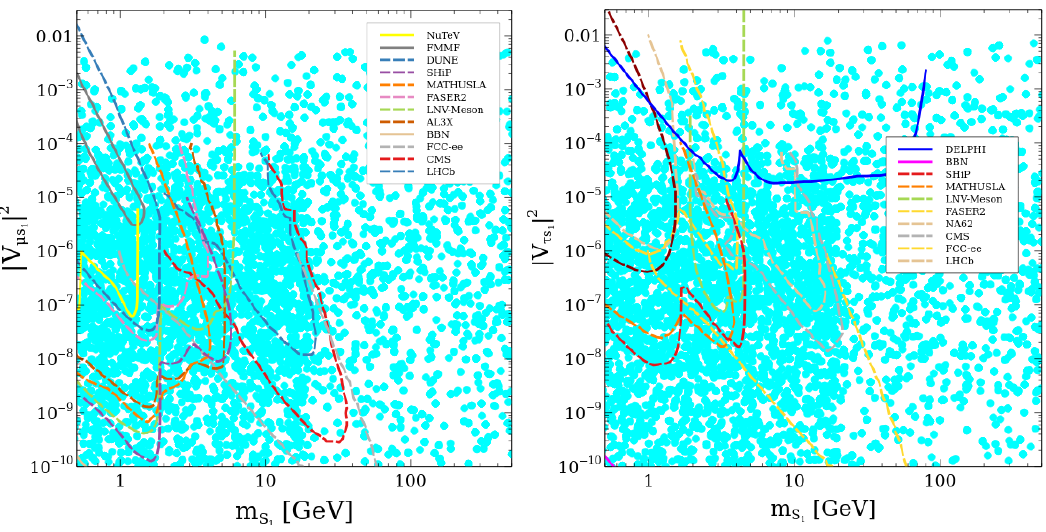
– | V – | V 2 (left) and m 2 (right) planes µS 1 | S 1 τS 1 | 1